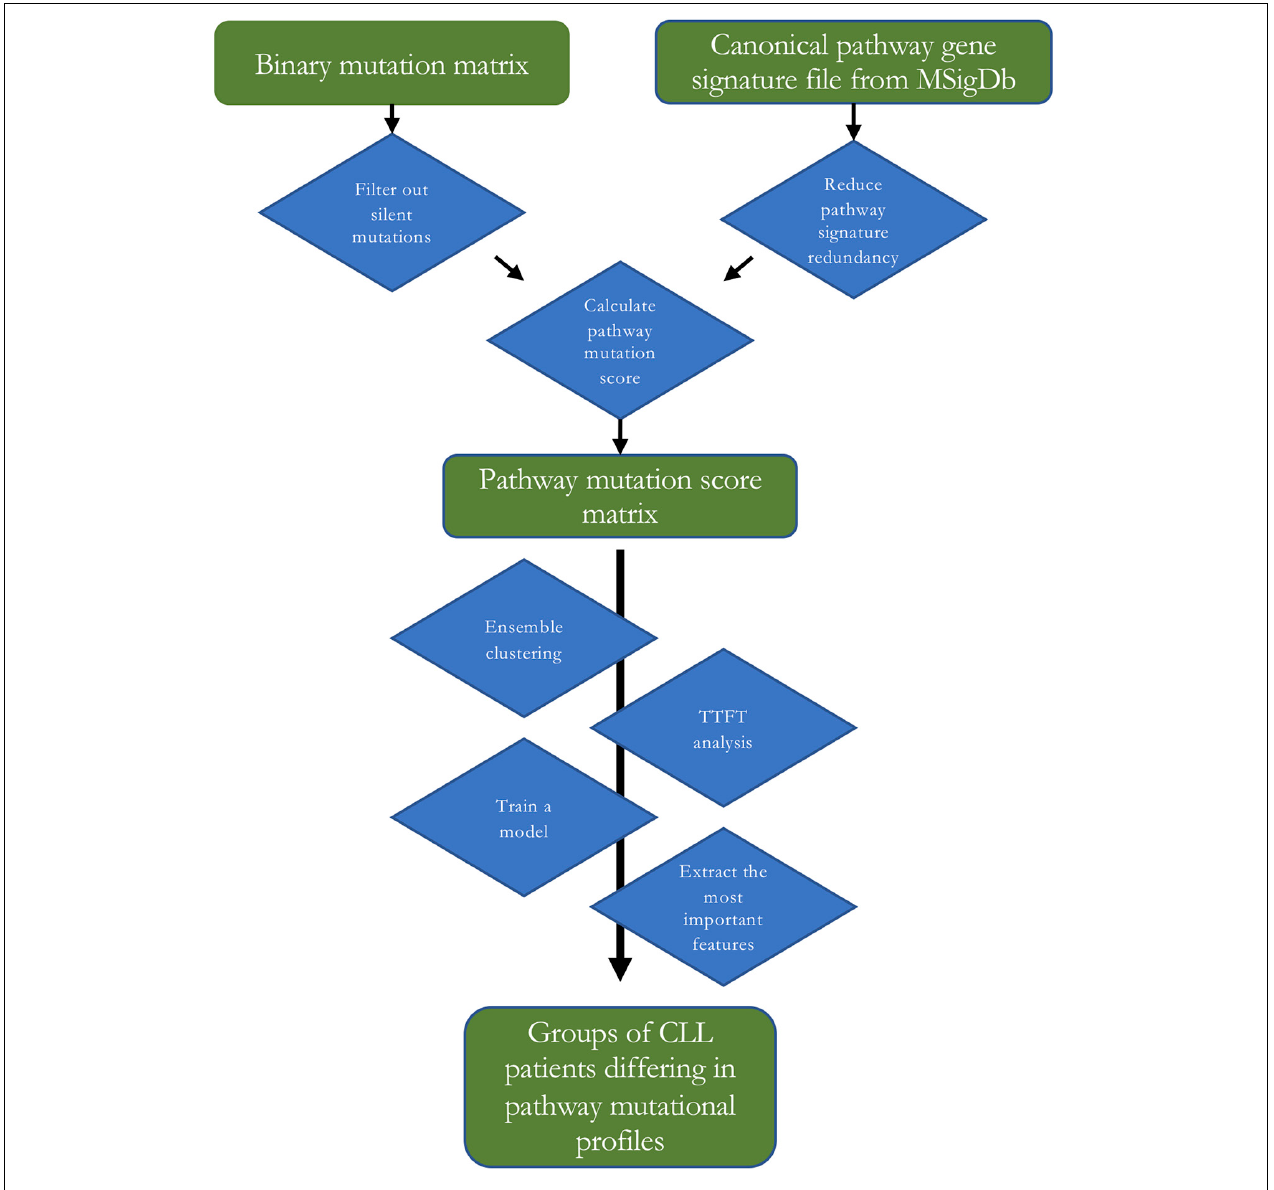
FIGURE 1 | A flow diagram of the analysis. TTFT – time to first treatment.